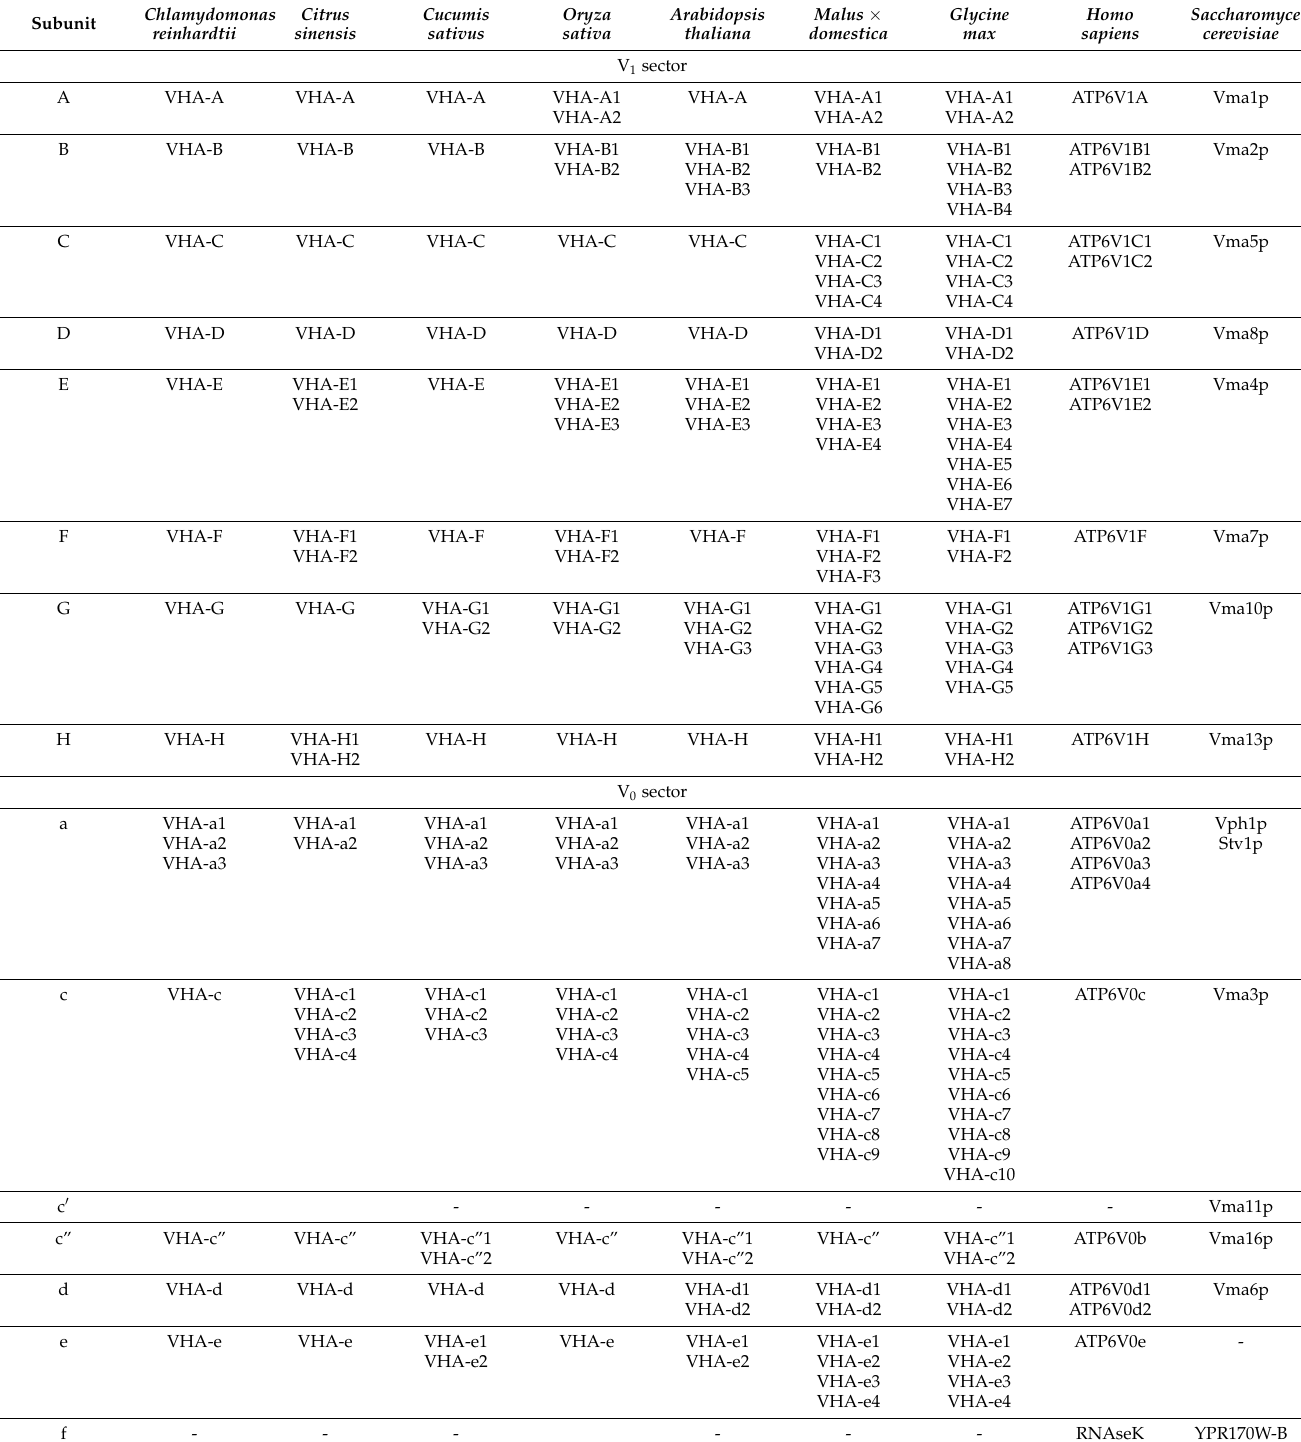
Table 1. Isoforms of V-ATPase subunits in different